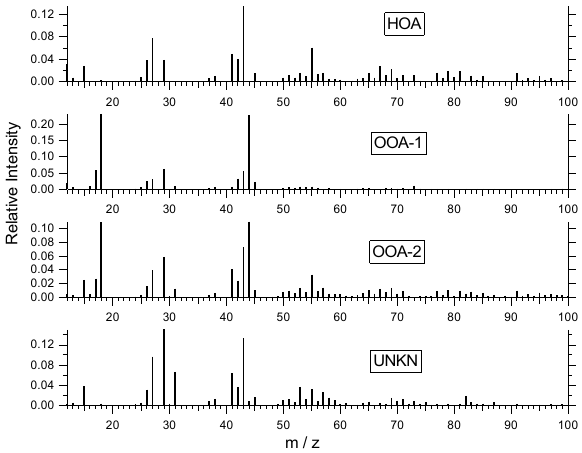
Fig. 1. Factor mass spectra for the 4-factor PMF solution to the combined Harrow/Bear Creek dataset obtained at f Peak=0.5. Fac- tor mass spectra are normalized such that each spectrum sums to 1 across all m/z